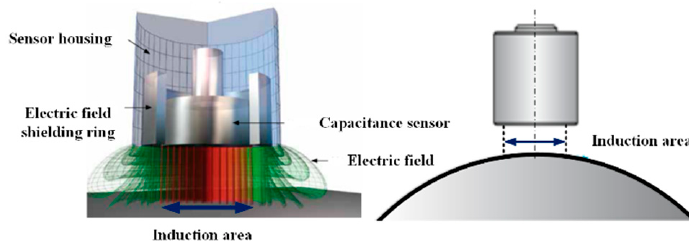
Figure 5. Nonlinear analysis of capacitive displacement sensor.